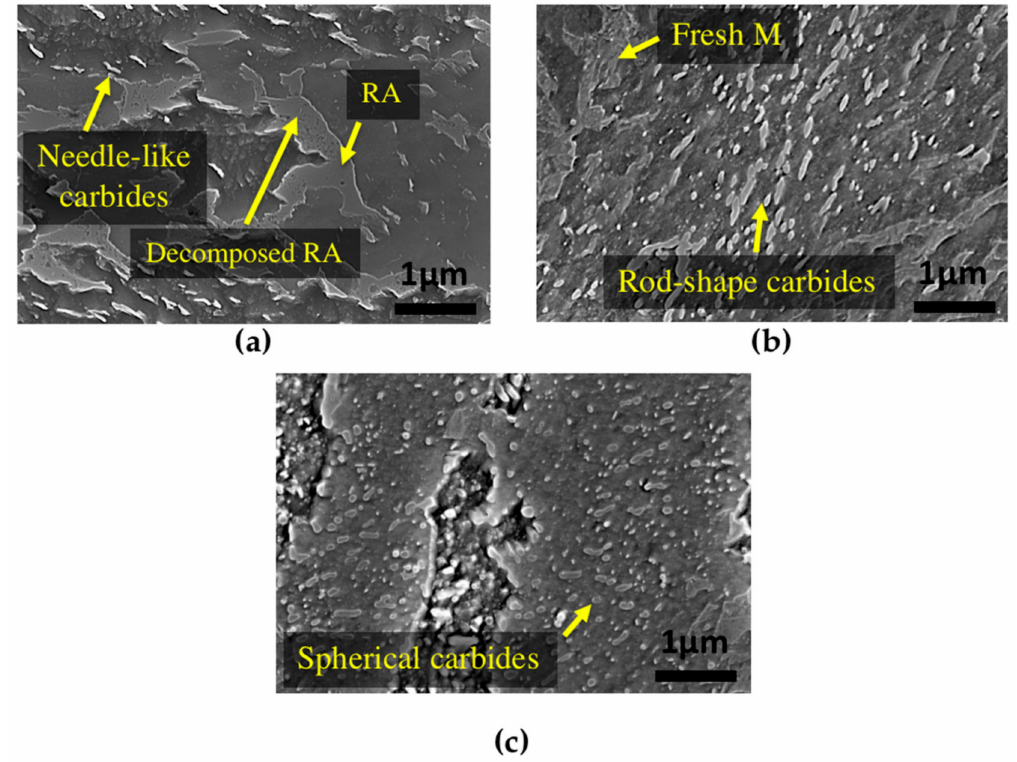
Figure 8. SEM images of bainitic specimens after tempering for 16 h at ( a ) 350 ◦ C; ( b ) 550 ◦ C and ( c ) 600 ◦